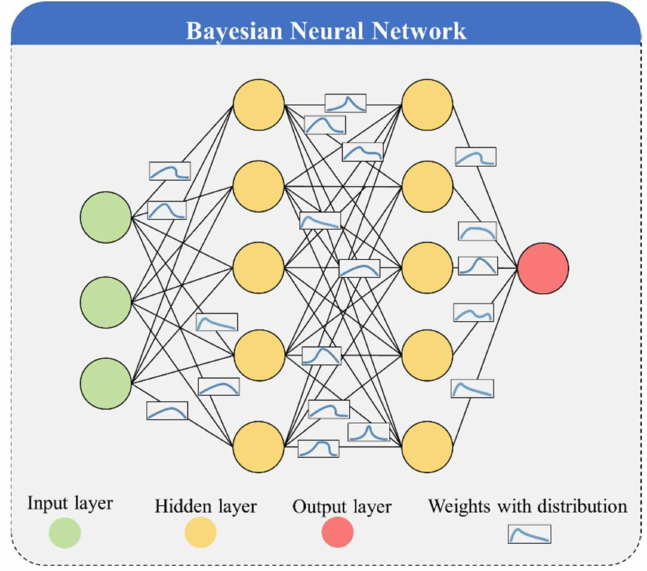
Figure 1. Structure of the Bayesian neural